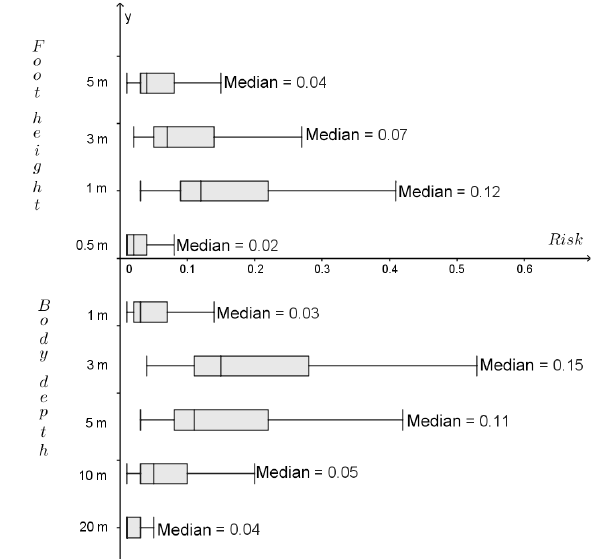
Figure 15. Box plots of the risk for the buildings per 5m pixel, for each scenario. Outliers are not shown. The maximum outlier values are 8.35 (foot height: 5m), 12.81 (foot height: 3m), 19.58 (foot height: 1m), 5.46 (foot height: 0.5m), 8.2 (body depth: 1m), 25.68 (body depth: 3m), 20.38 (body depth: 5m), 9.62 (body depth: 10m), and 2.99 (body depth: